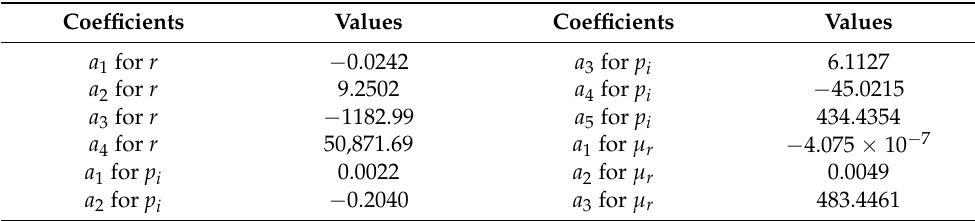
( b ) Figure 23. Physical dimensions of the shields. ( a ) Conventional structure. ( b ) Proposed structure. 4.2. Finite Element Analysis The main parameters of the coupler with the proposed structure are listed in Table 4, and the model of secondary side is shown in Figure 24. Table 4. Main coupler parameters with the proposed structure shield. Symbol